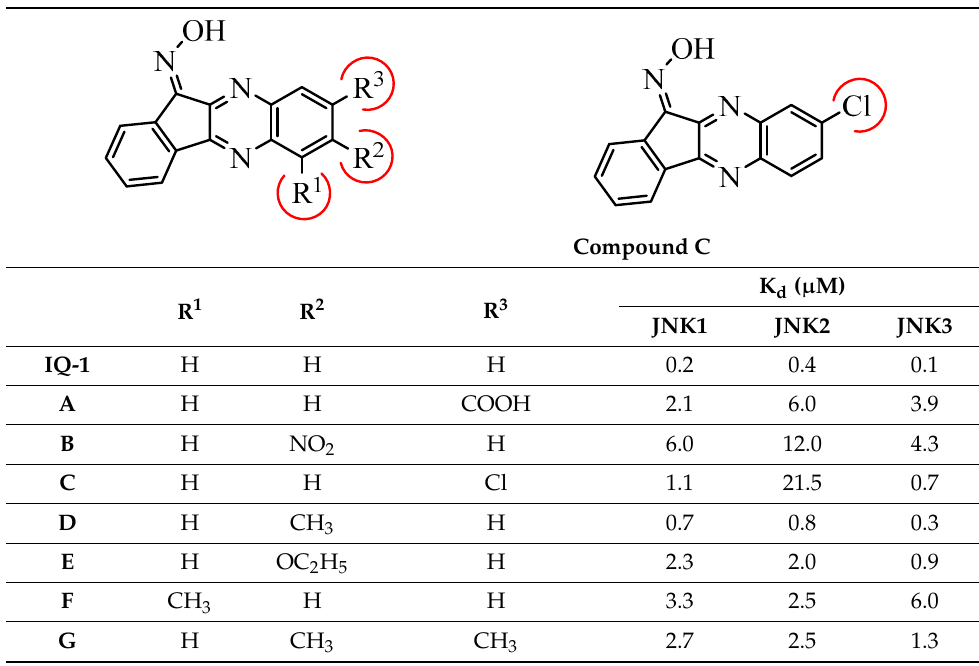
Table 1. Chemical structure and activity of previously identified JNK1-3 inhibitors with an 11 H - indeno[1,2- b ]quinoxalin-11-one scaffold containing different substituents in the tetracyclic moi- ety [35,36].